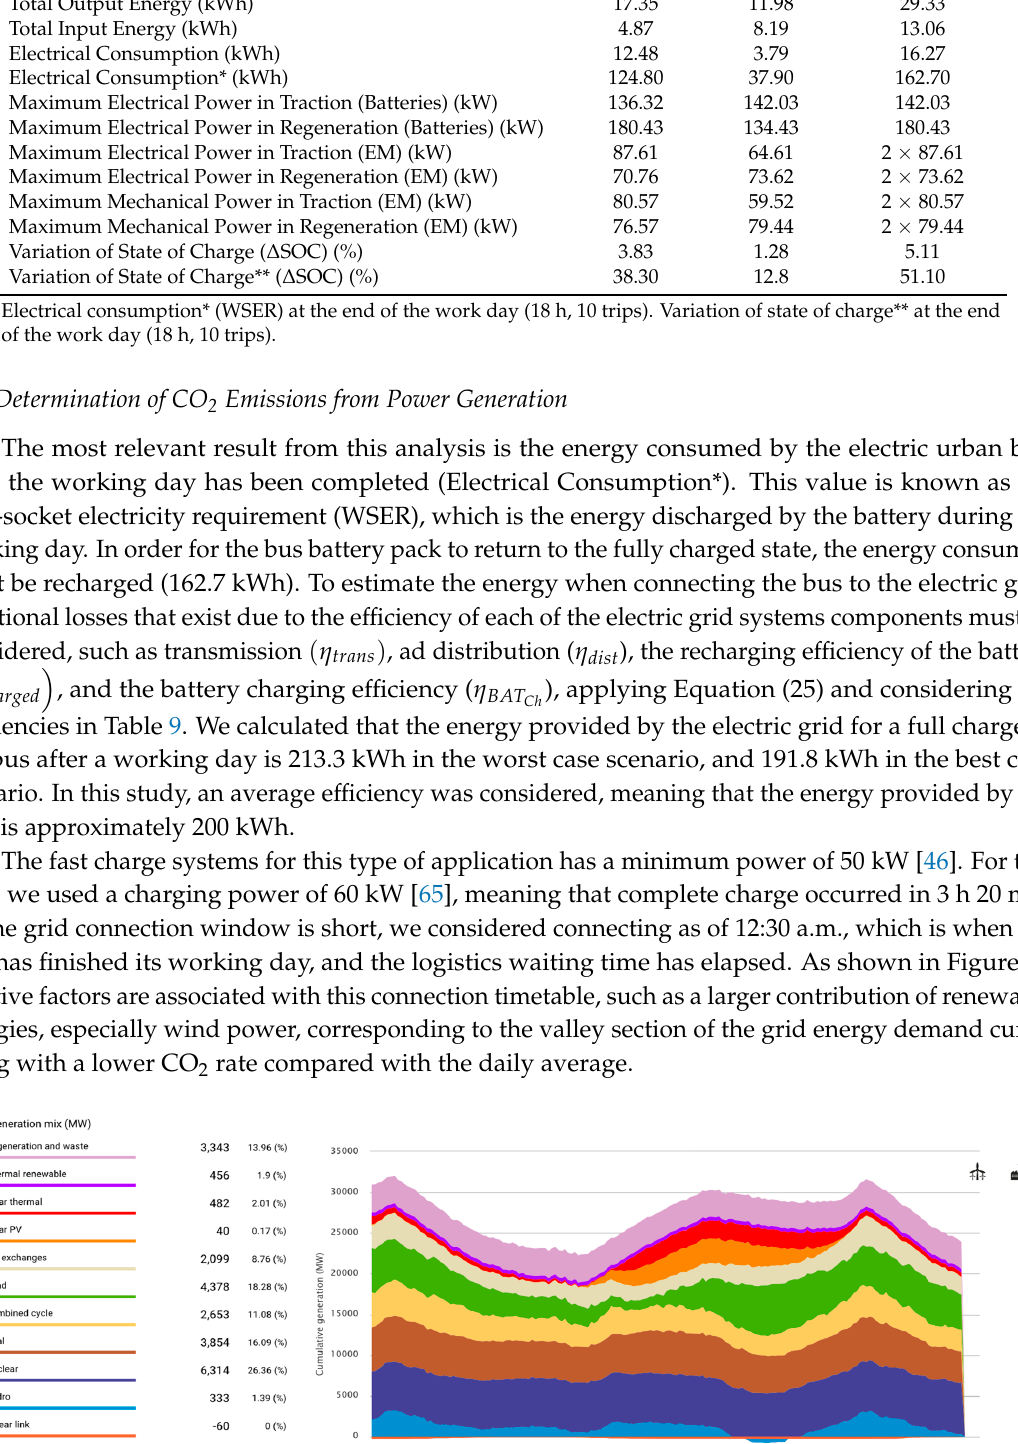
Table 12. Relevant results obtained during the route simulation.